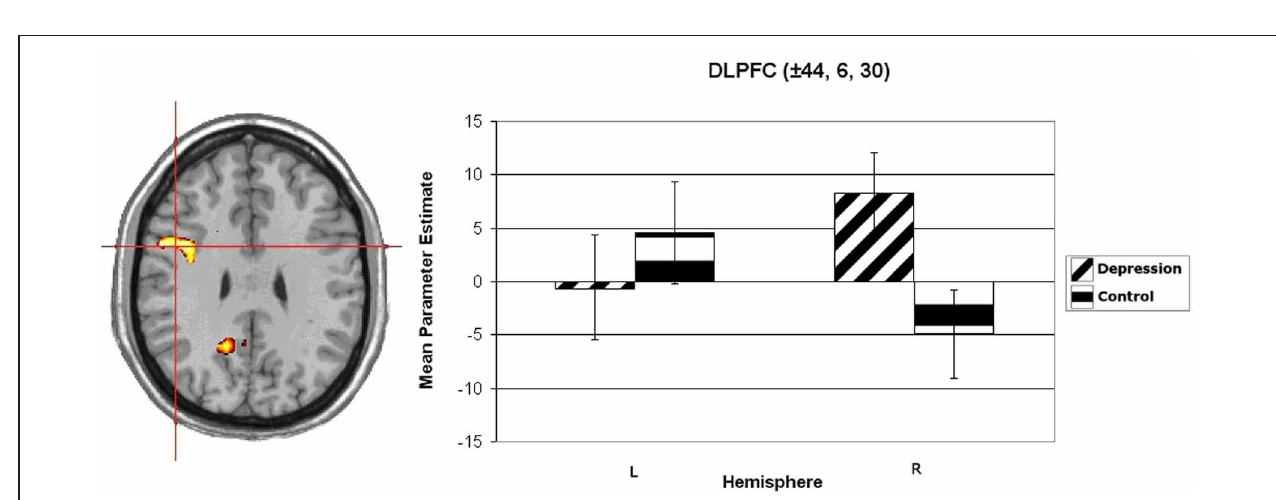
FIGURE 3 | Group × Hemisphere interaction for unpleasant vs. neutral word activation in dorsolateral prefrontal cortex (DLPFC). Activation is arbitrarily overlaid on left-hemisphere anatomy, as hemisphere was included as a factor in the analysis. The red crosshairs are placed over the center of effect size for the cluster. Panel on right